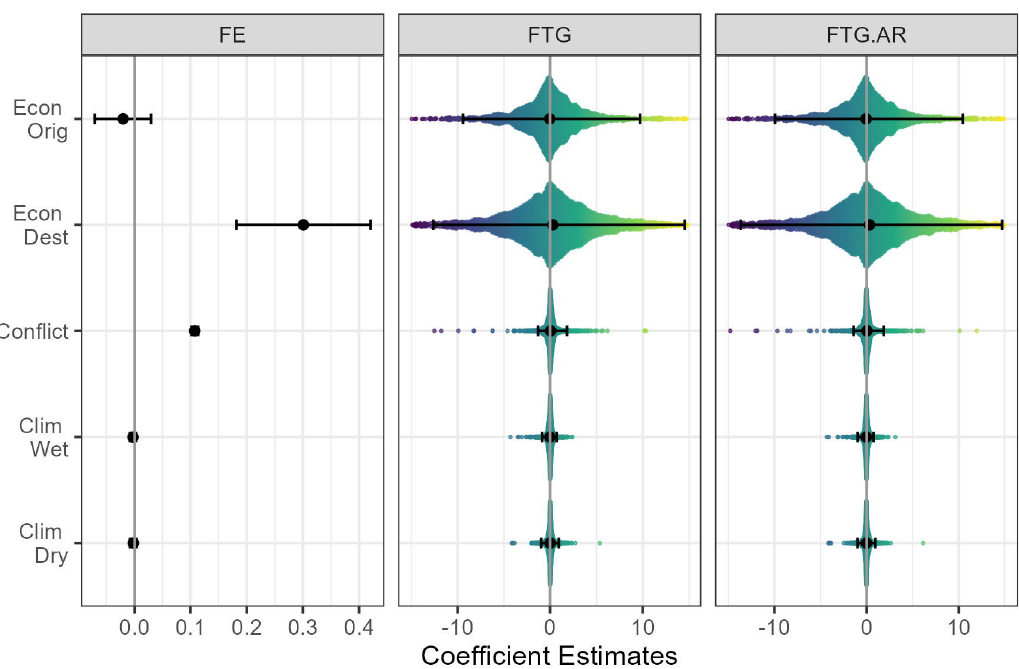
Fig 5. Coefficient estimates by FE and FTG models. Note: The solid bands in FE model represent the 95% confidence intervals of the point estimates, and that in FTG model contain 95% of the estimated flow-specific coefficients.